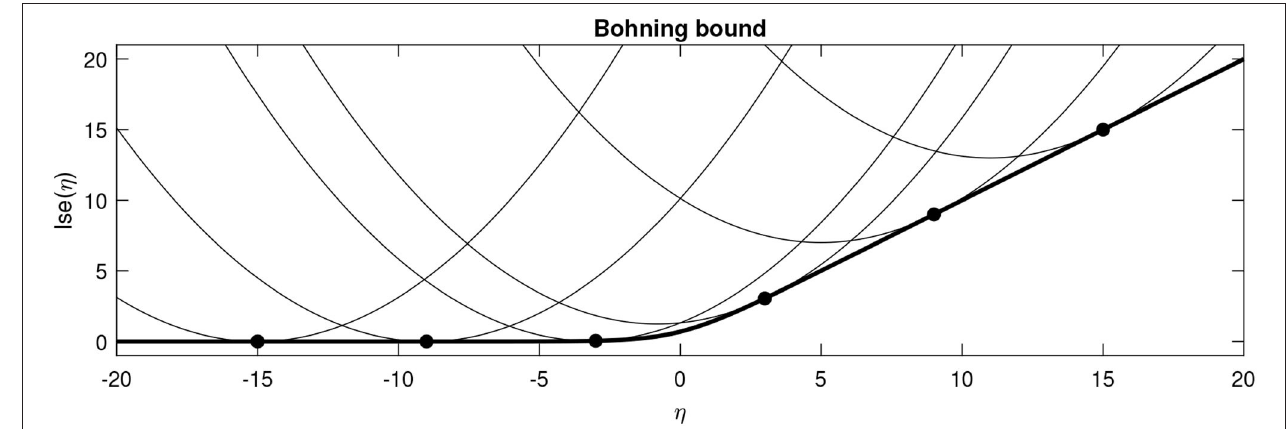
FIGURE 2 | Böhning’s bound plotted for various values of ˆ η for the binary case. The thick line shows the actual lse function, whereas the fine lines show the local quadratic approximations centred around various points (solid circles).